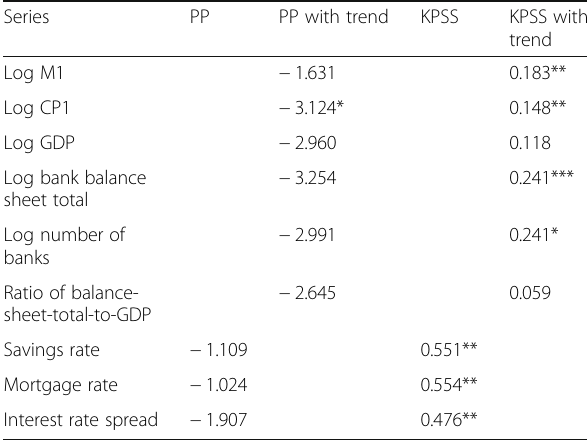
Table 1 Unit root and stationarity tests, 1851 –